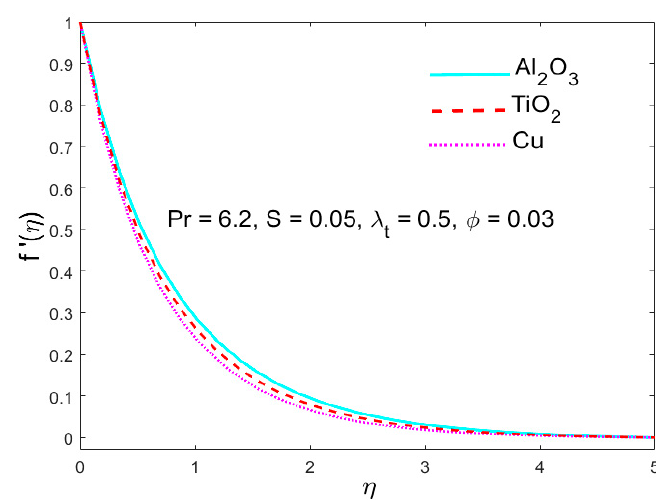
Appl. Sci. 2020 , 10 , x FOR PEER REVIEW Figure 10. Effect of different nanoparticles on the velocity profile. Figure 10. E ff ect of di ff erent nanoparticles on the velocity profile. Figure 10. Effect of different nanoparticles on the velocity profile.